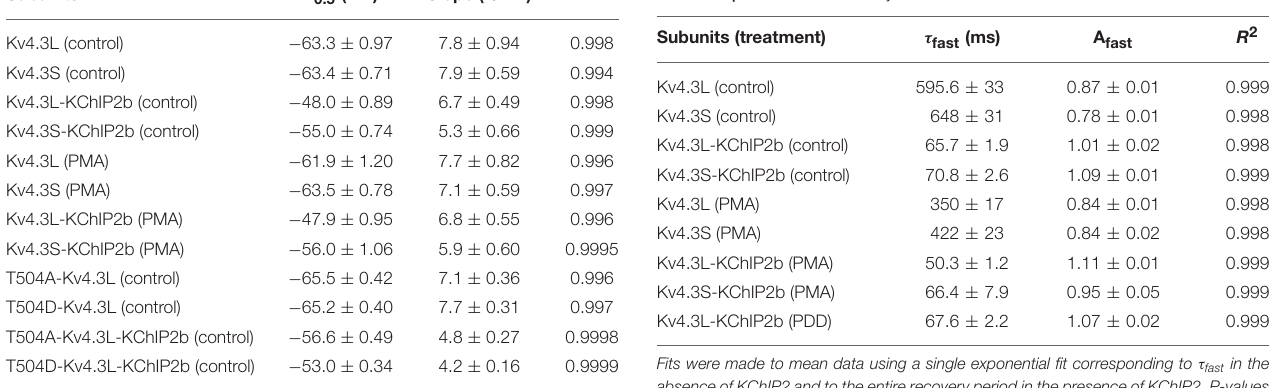
TABLE 2 | Inactivation recovery kinetics.